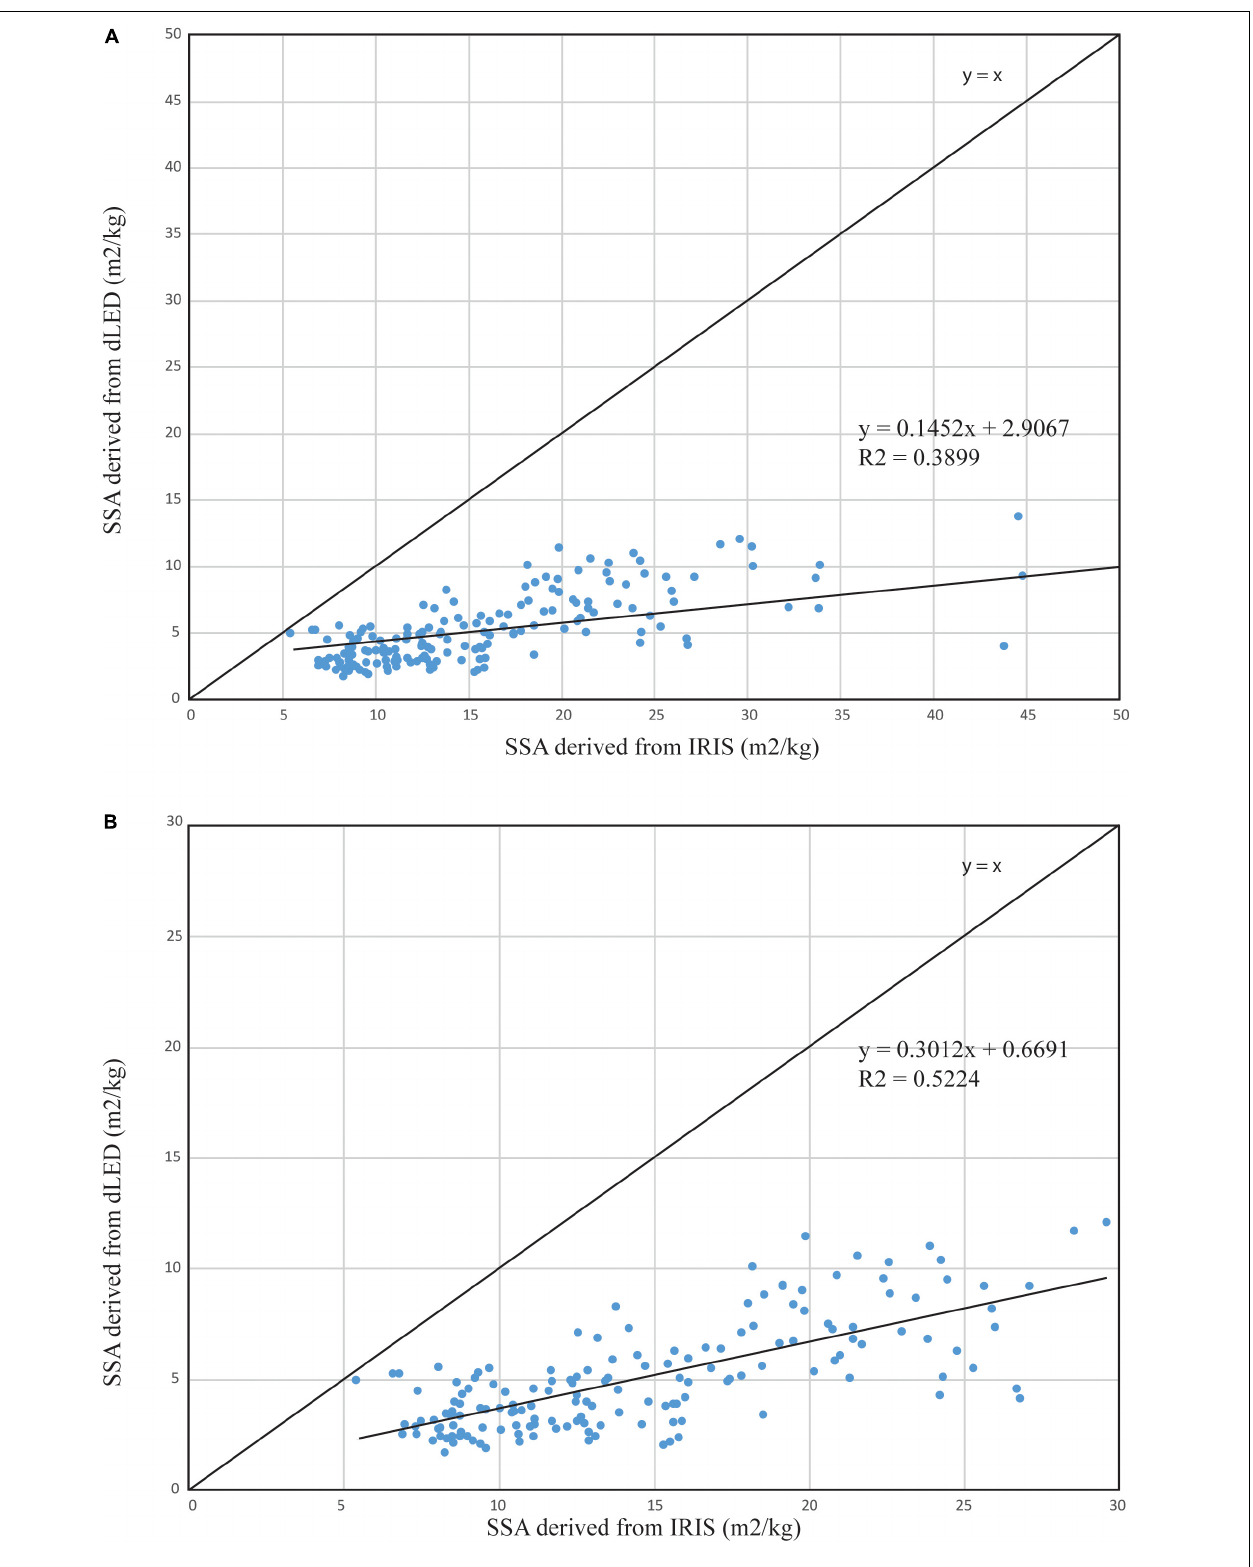
FIGURE 10 | Comparison between specific surface area (SSA) measured with both IRIS and dLED for (A) the whole dataset and (B) measured over the value range of 0–30 m 2 /kg from IRIS (considered here as the reference).